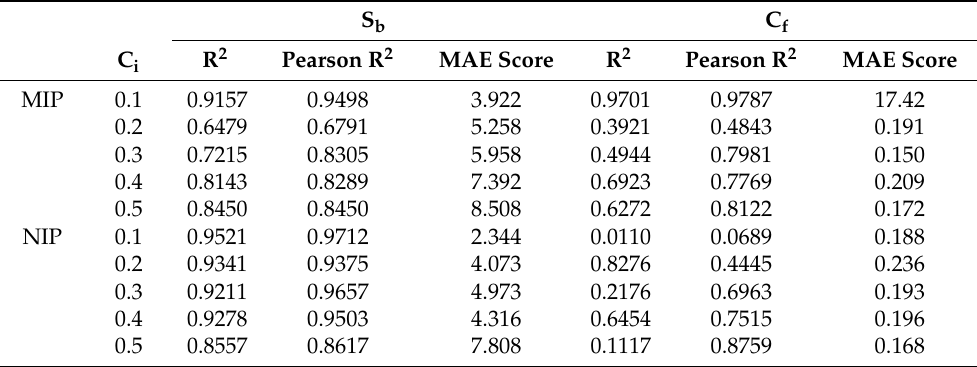
Table 3. Analysis of the error and correlation of the trained datasets at a given C i value for the multitask regressor model. S b